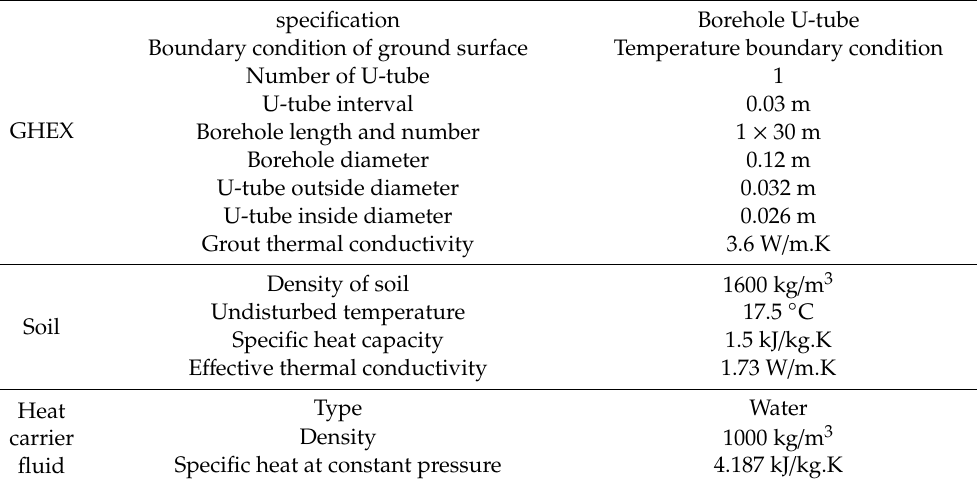
Figure 3. Diagram of thermal response test. Table 1. Calculation